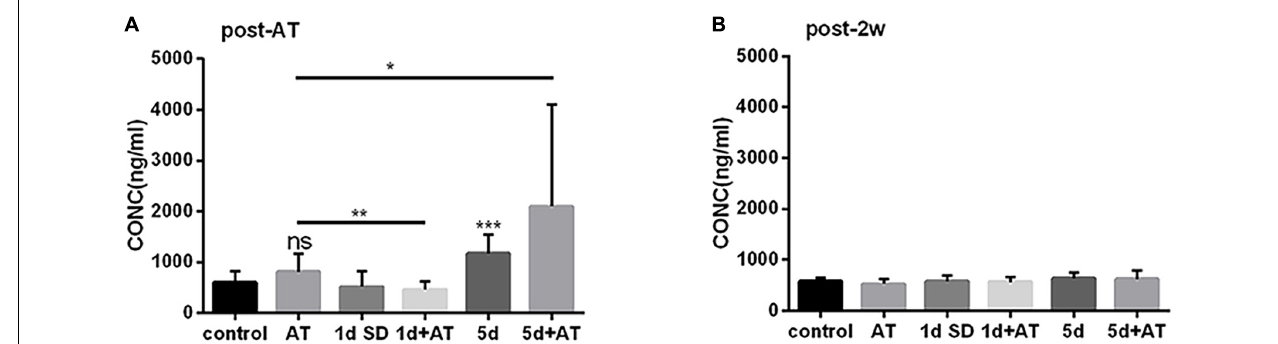
FIGURE 4 | The changes in serum corticosterone concentration induced by SD. (A) Serum corticosterone concentration at post-AT. The corticosterone level was almost doubled in 5d SD group ( n = 12) than that of the control group ( n = 12). The 5d + AT group ( n = 12) had higher corticosterone concentrations than the AT group ( n = 12). There was no significant difference between the 1d SD group ( n = 15) and the control group in serum corticosterone concentration. Significant reduction of serum corticosterone level was observed in the 1d + AT group ( n = 15) as compared to the AT group ( n = 12). (B) Corticosterone concentration of serum at post-2w. No significant differences of the corticosterone levels were seen among six groups at the time point of post-2w. The data are shown as the mean ± SD. Two-tailed, unpaired Student’s t -tests were used to determine statistical significance.